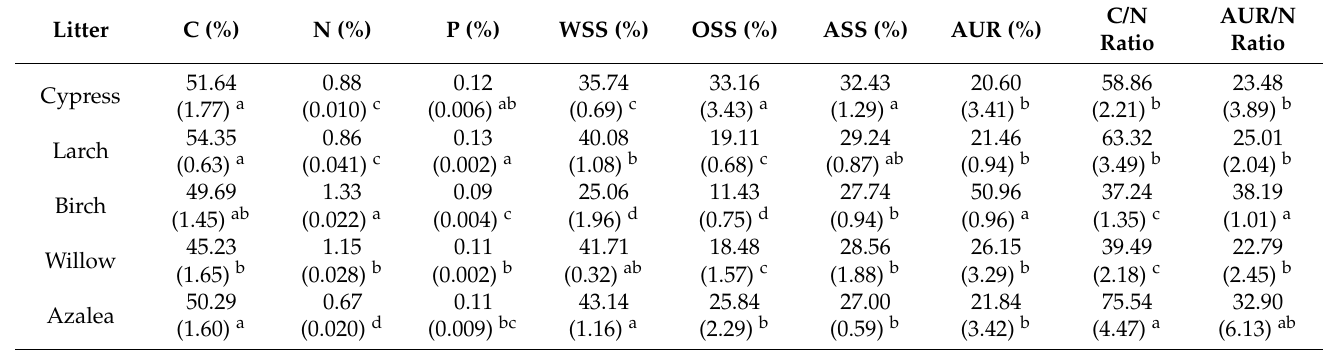
Table 2. Initial chemical compounds in the five foliar litters used in our long-term decomposition experiment. Data from Ni et al. [31,36]. Values are means and standard deviations in parentheses ( n = 3). Different superscript letters in the same column represent significant ( p < 0.05)